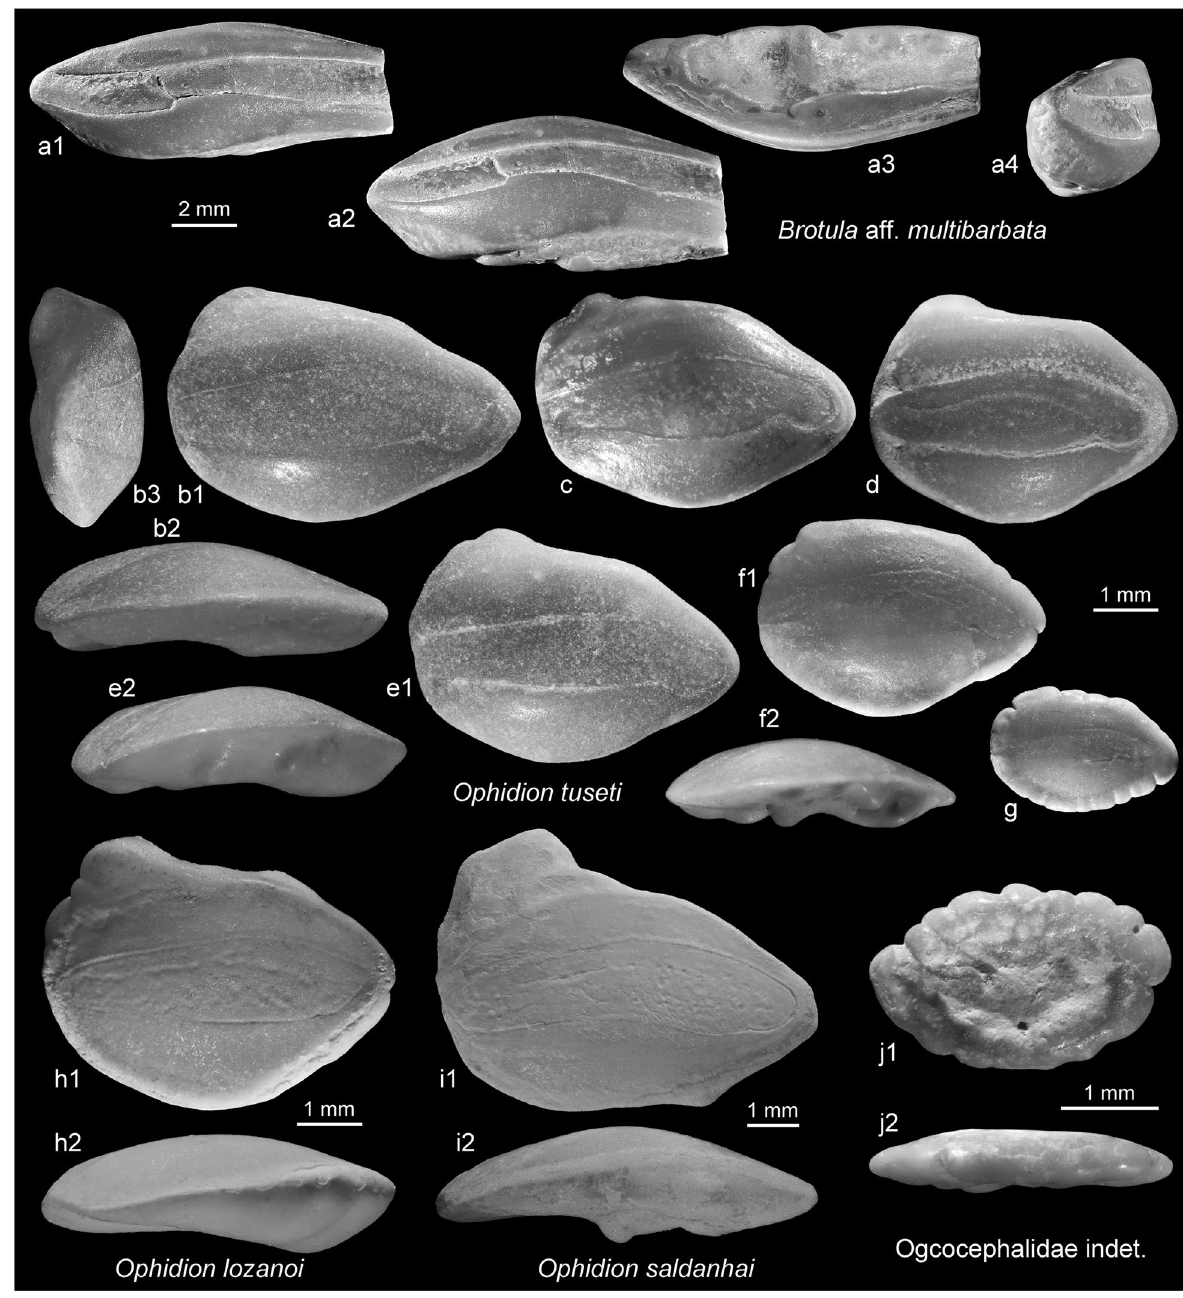
Fig. 16 Ophidiiformes. a , Brotula aff. multibarbata Temminck & Schlegel, 1846, SMF PO 101.215 (reversed), Dar bel Hamri. b – g , Ophidion tuseti n. sp., Dar bel Hamri, Zanclean, b holotype, SMF PO 101.217 (reversed), c – g paratypes, SMF PO 101.218 ( c , e – g reversed). h , Ophidion lozanoi Matallanas, 1990, Holocene dredge samples off Nigeria, refigured from Schwarzhans (2013a). i Ophidion saldanhai Matallanas & Brito, 1999, extant, Gabon, leg. ZMUC (reversed). j , Ogcocephalidae indet., SMF PO 101.276, Dar bel